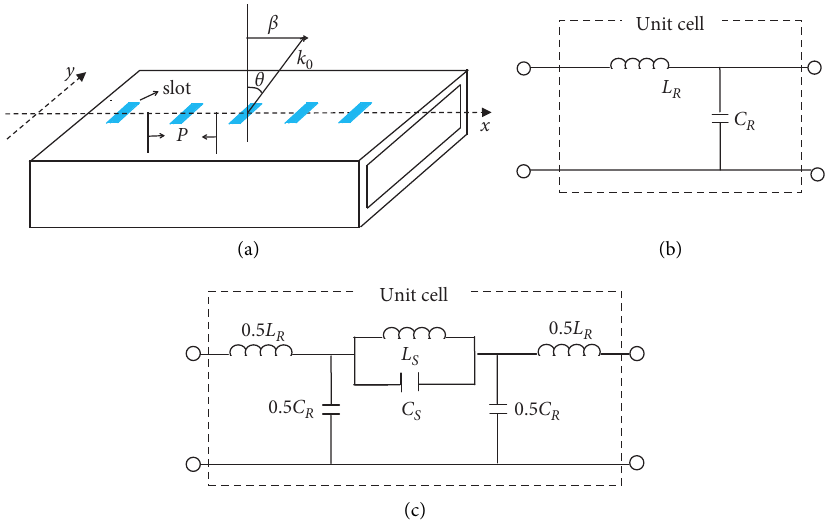
Figure 1: Rectangular waveguide: (a) configuration of whole structure with periodic transverse slots; (b) equivalent circuits for a section of closed rectangular waveguide; (c) equivalent circuits for one period of leaky rectangular